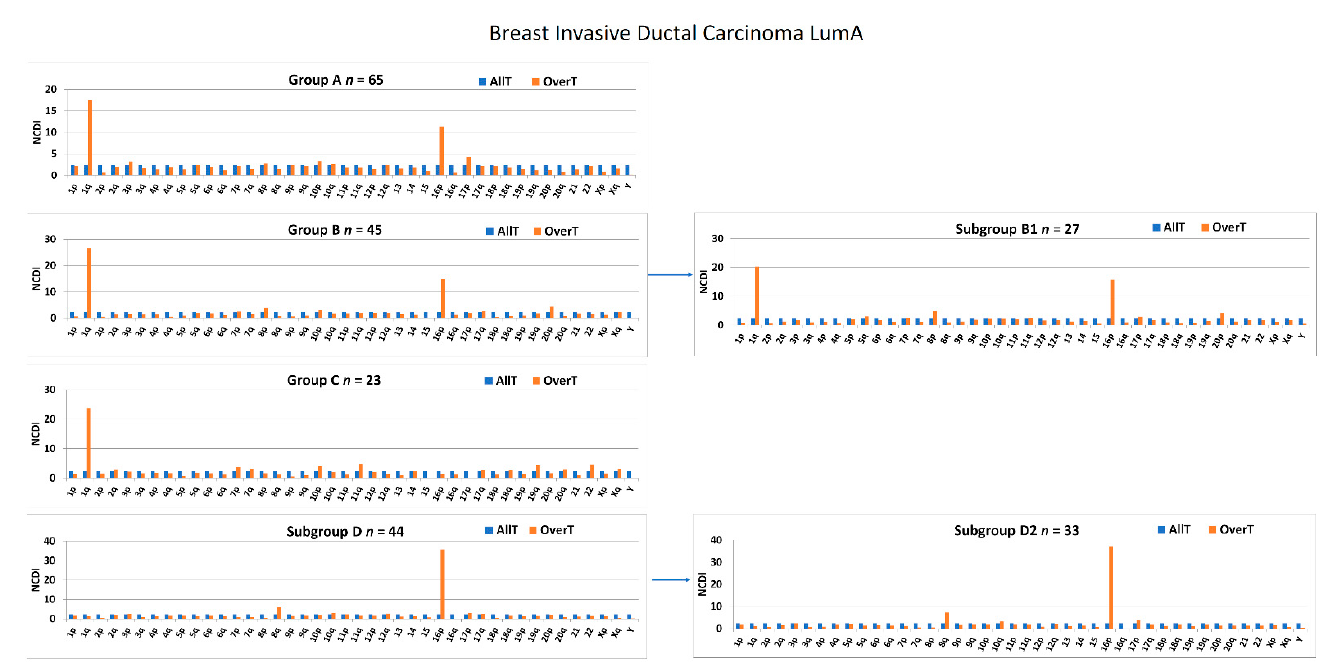
Figure 11. NCDI values of OverT of each 1,16-chromogroup formed with breast invasive ductal carcinomas of the LumA subtype. NCDI values of all transcripts (AllT) analyzed by RNA-seq in each chromosomal arm are also reported for comparison.